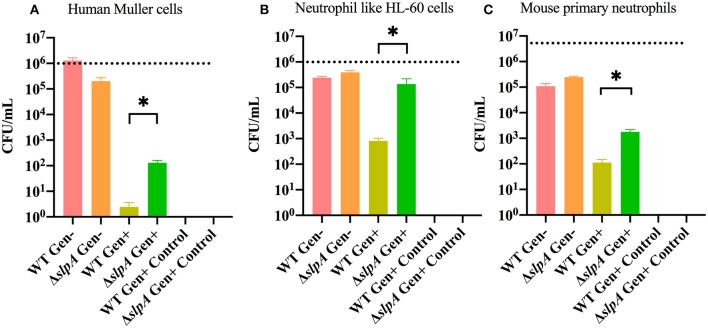
Bacillus SLP provides protection from phagocytosis. Muller cells, neutrophil-like HL60 cells, and mouse primary neutrophils were incubated with WT or ΔslpA B. thuringiensis for 90 min. Cells were then treated with gentamicin for 60 min to kill external bacteria. Compared to WT B. thuringiensis, internalization of ΔslpA B. thuringiensis was significantly greater by (A) human retinal Muller cells, (B) neutrophil-like HL-60 cells, and (C) mouse primary neutrophils. Gen+, Gentamicin treated; Gen-, Gentamicin untreated. Values represent mean ± SEM of N ≥ 5 for at least two separate experiments; *P < 0.05. Dashed lines represent the initial bacterial inoculum.